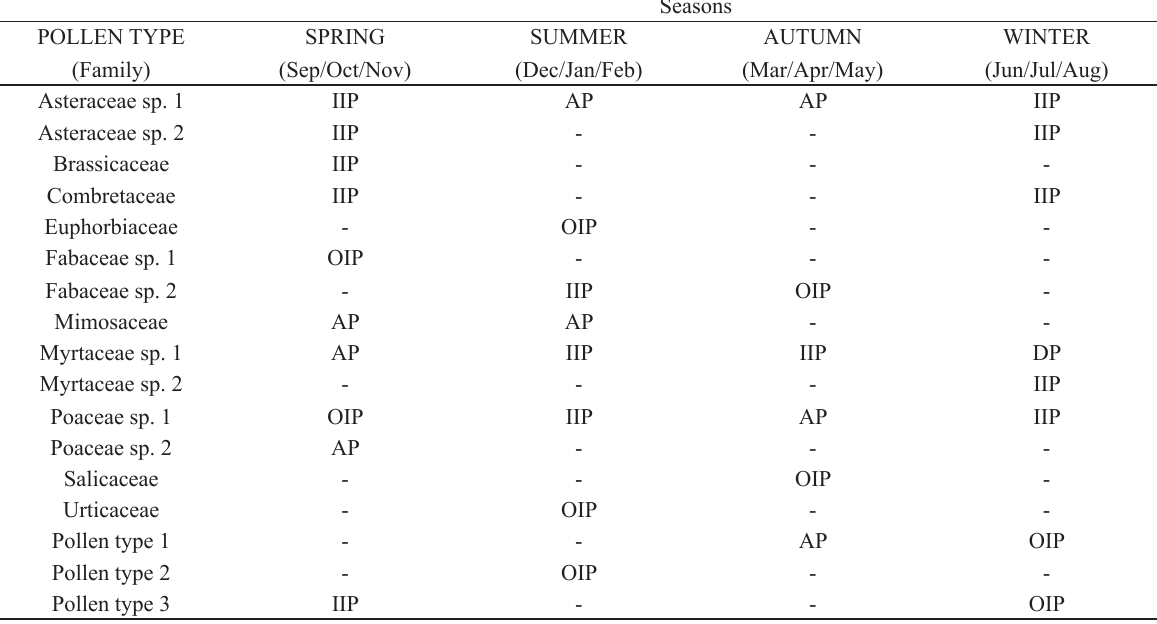
Quantitative analysis by counting 300 pollen grains. Dominant Pollen (DP) - over 45% of total pollen sum; Accessory Pollen (AP) - 15 to 44%; Isolated Important Pollen (IIP) - 3 to 15% and Occasional Isolated Pollen (OIP) - less than 3%.